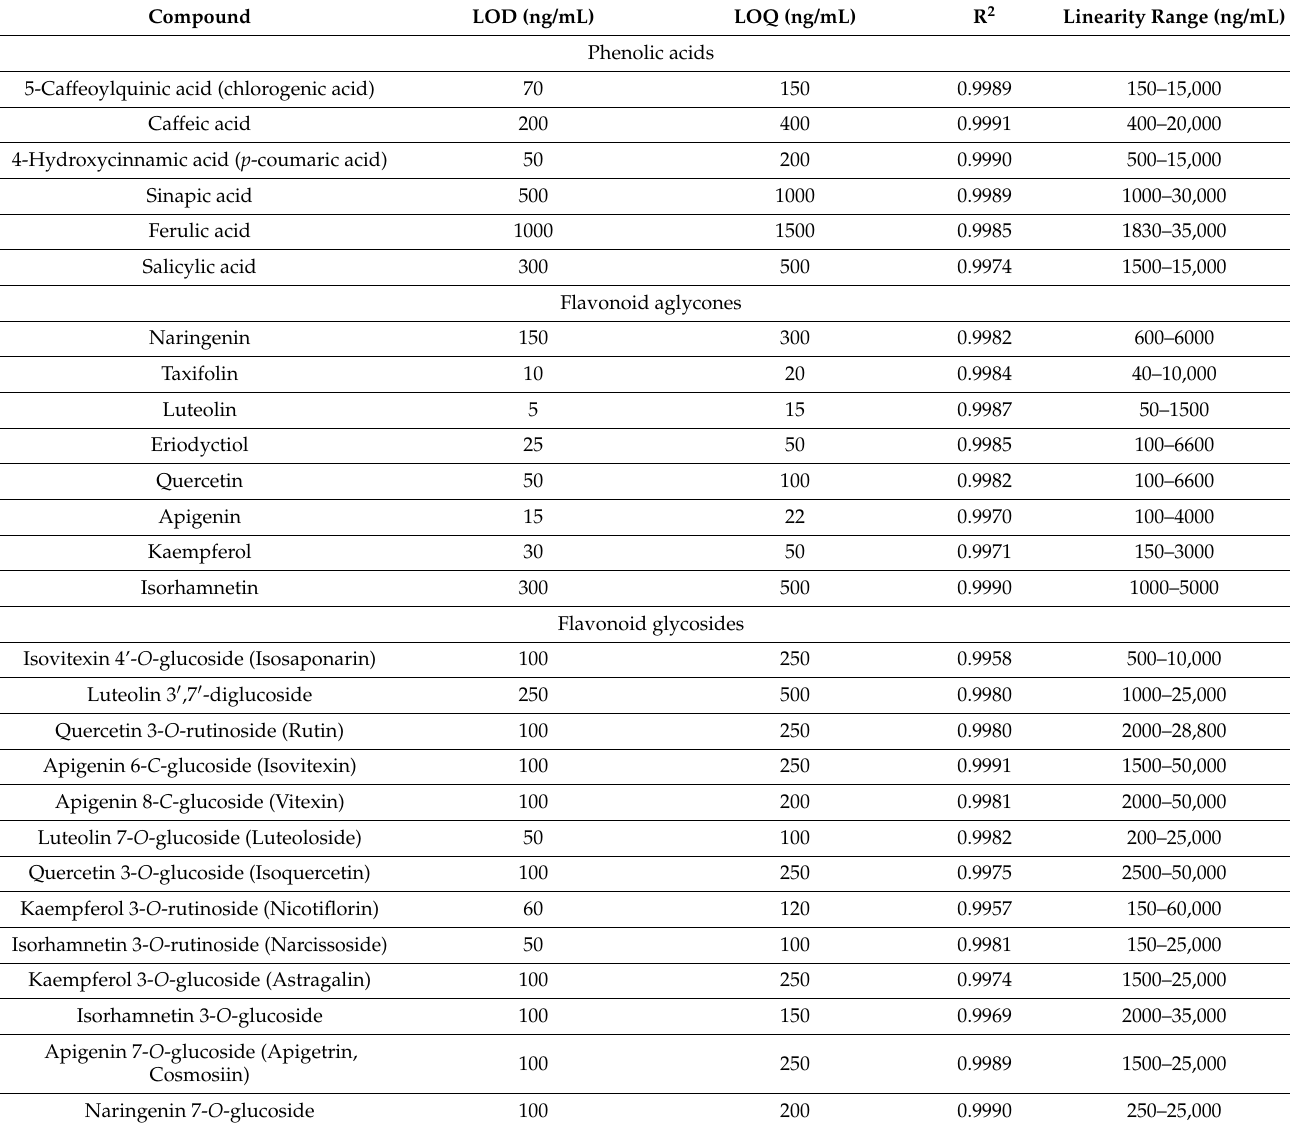
Table 9. Analytical results of the LC-ESI-MS/MS quantitative method of the phenolic acids and flavonoids. Limit of quantification (LOQ), limit of detection (LOD), and calibration curve